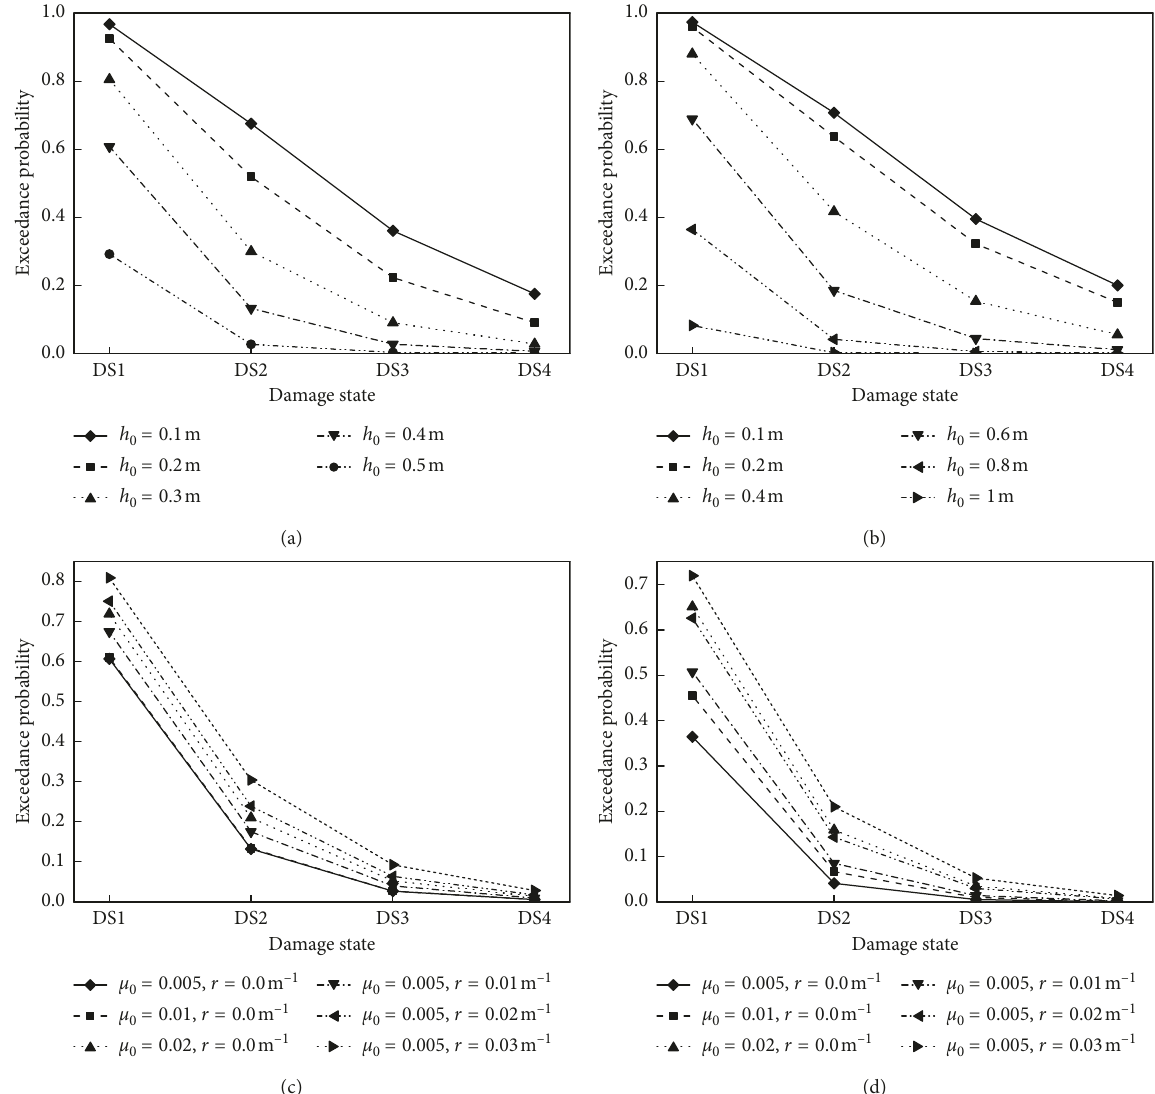
Figure 10: Structural peak acceleration when K DS4 are defined by the structural peak acceleration in Table 2). (a) μ 0 (c) h 1 0 . 5m, h 0 0 . 4m. (d) h 1 (cid:31) (cid:31)